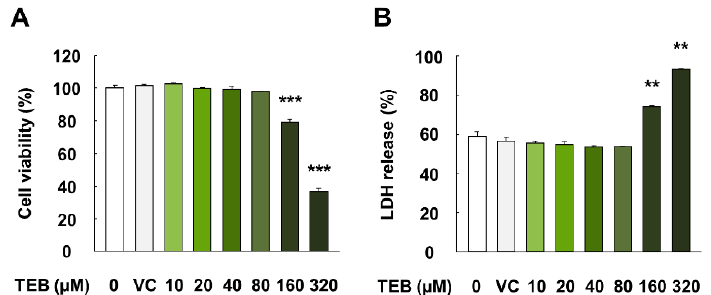
Figure 1. Cell viability and membrane integrity (LDH release) in HepG2 cells treated with TEB. ( A ) Percentage of cell viability and ( B ) LDH release in HepG2 cells. The cells were exposed to TEB (10, 20, 40, 80, 160, and 320 µM) or DMSO as a vehicle control (VC) for 24 h ( n = 3 wells/group). The data are represented as mean ± SEM. ** ( p < 0.01) and *** ( p < 0.001) indicate a significant difference.